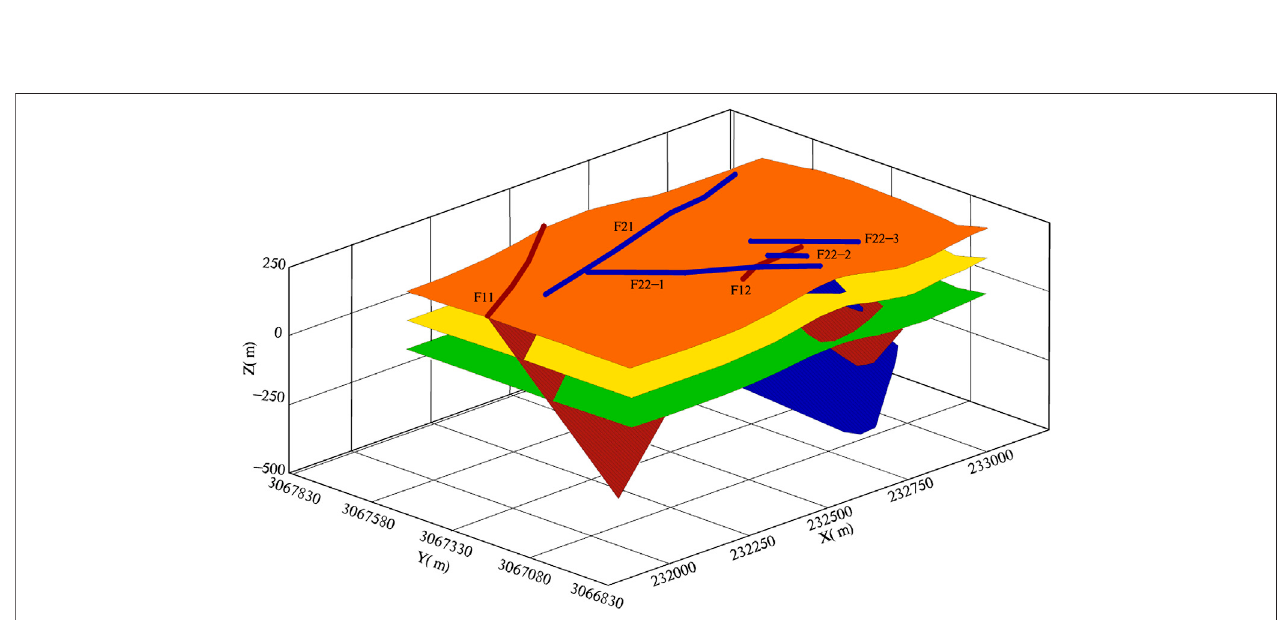
FIGURE 12 | The 3D model with multifaults (the different colors represent the geological domain depicted in Figure 2 , in which the blue color represents the focused fault area in the numerical model).